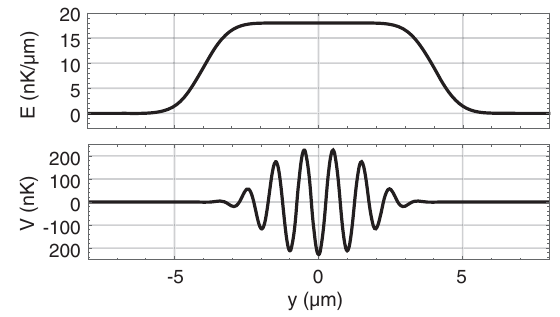
FIG. 9. Profiles of the fictitious electric field (top) and the lattice potential (bottom) used in the numerical